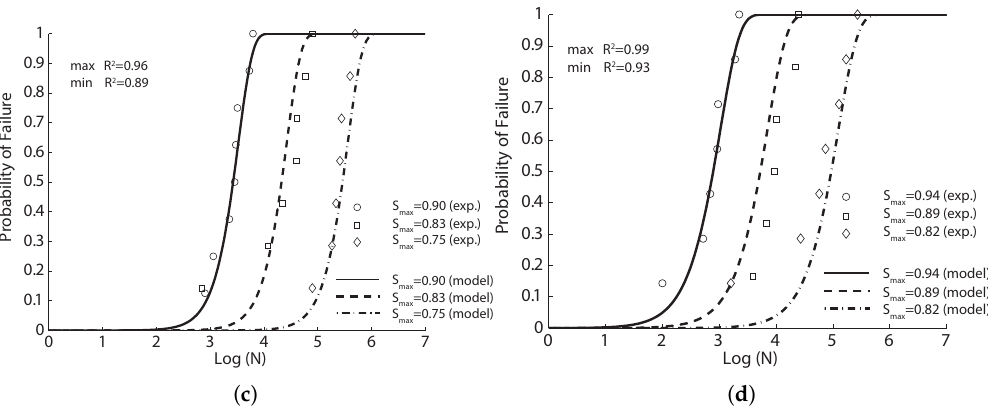
Figure 3. Comparison of flexural fatigue data of Johnston and Zemp [41] with the fitted probabilistic model Equation (8) for concrete reinforced with 1.0% steel fibers of ( a ) SW(50); ( b ) SDW(47); ( c ) ME(54) and ( d ) SS(71) indicated as fiber type(aspect